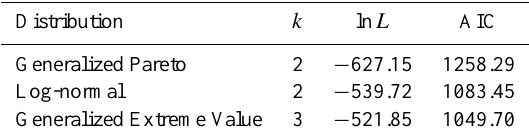
Table 2. The maximum values of the log-likelihood function (ln L ) and the corresponding values of the Akaike Information Criterion (AIC) for the model distribution functions considered to fit the rescaled distributions given in Fig.